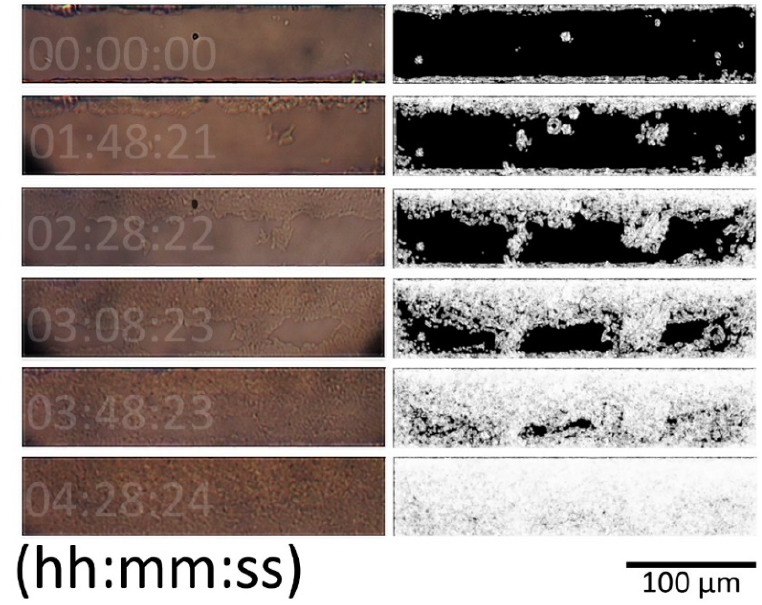
Figure A3. Microchannel section micrographs and processed images for bacterial growth Figure A2 . Microchannel section micrographs and processed images for bacterial growth estimation.